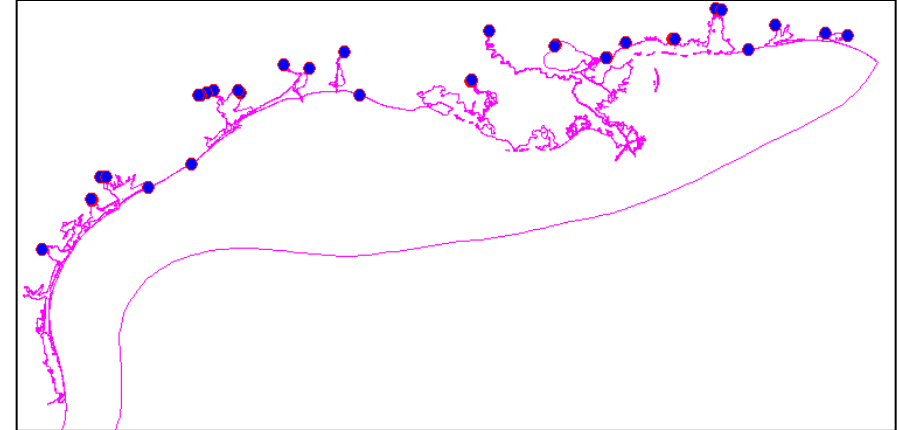
Figure 6. River forcing locations on the INGOFS grid. Discharges of the 18 rivers total are distributed across 63 grid nodes.